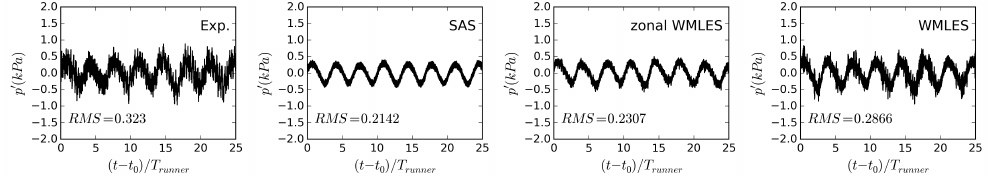
Figure 6. The signal of pressure fluctuations at Probe 2 shown in Figure 2a in the experiment and